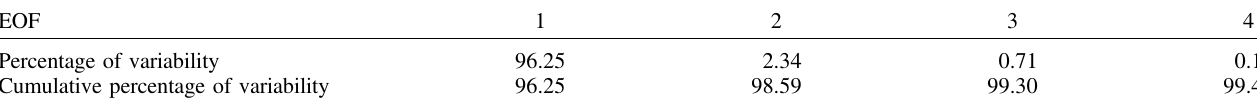
Table 1. The percentage of data variability captured by the fi rst four Empirical Orthogonal Functions (EOFs) EOF